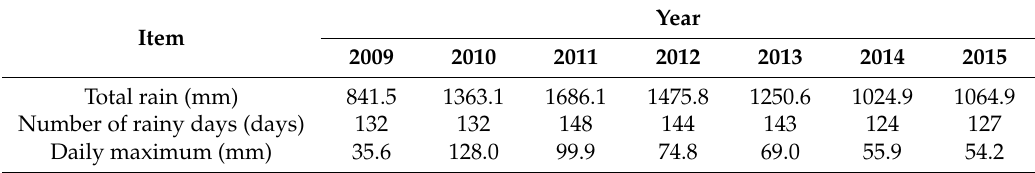
Table 2. Rainfall statistics as recorded at Mae Hong Son Meteorological Station for 2009–2015.